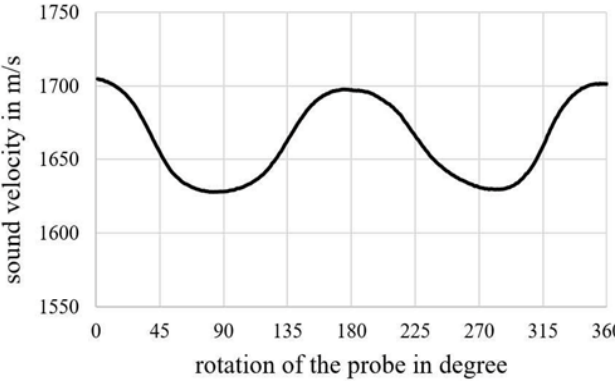
Figure 24. Polarization velocity curve measured in a UD GFRP plate.